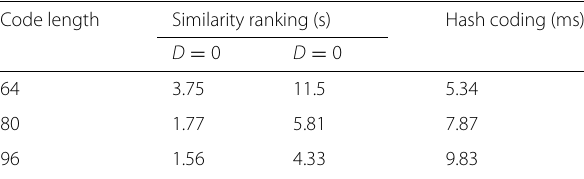
Table 1 Similarity rankings and encoding times using 64, 80,